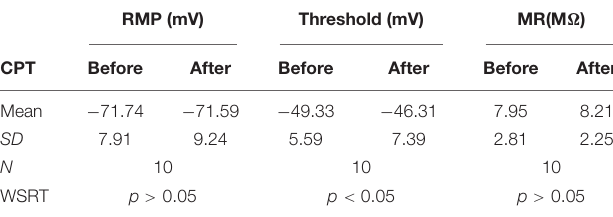
TABLE 2 | Effects of CPT on membrane